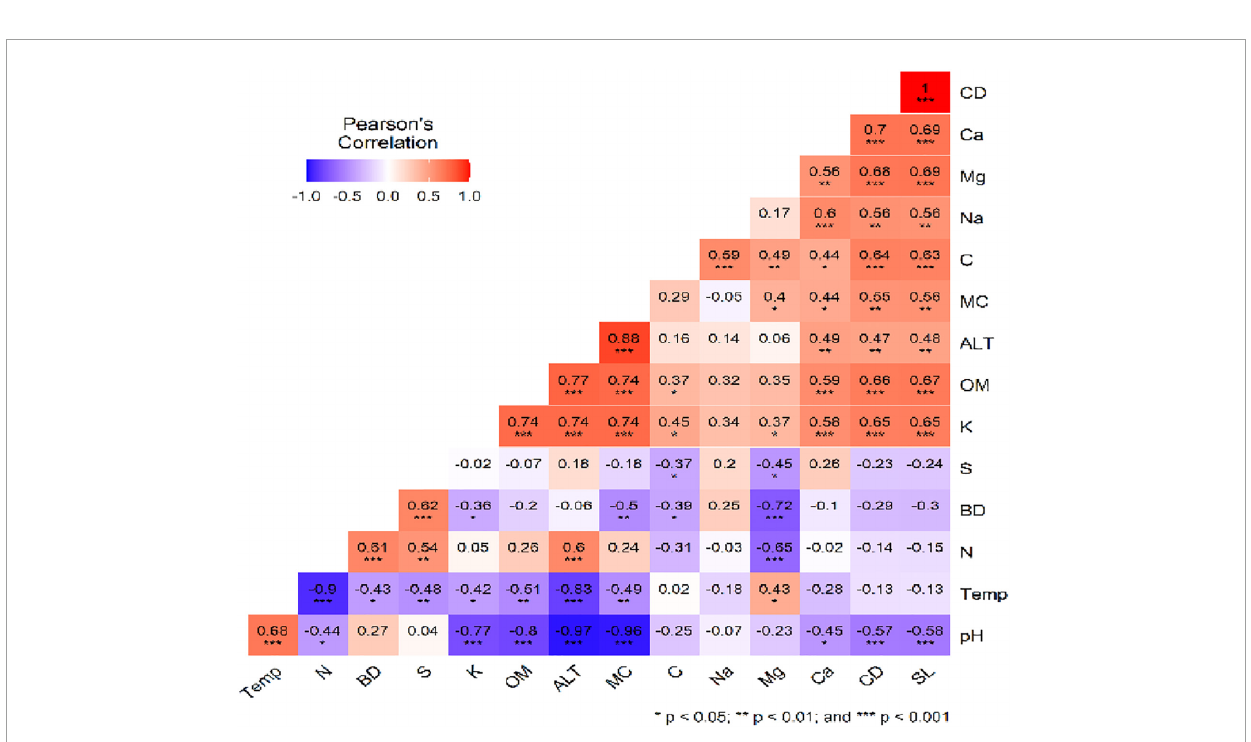
FIGURE4 Pearson’s correlation plot among studied soil physico-chemical parameters. The distribution of each variable and correlation coefficient plus the significance level is given in the figure. Full forms of abbreviations are presented in Figure 2 .